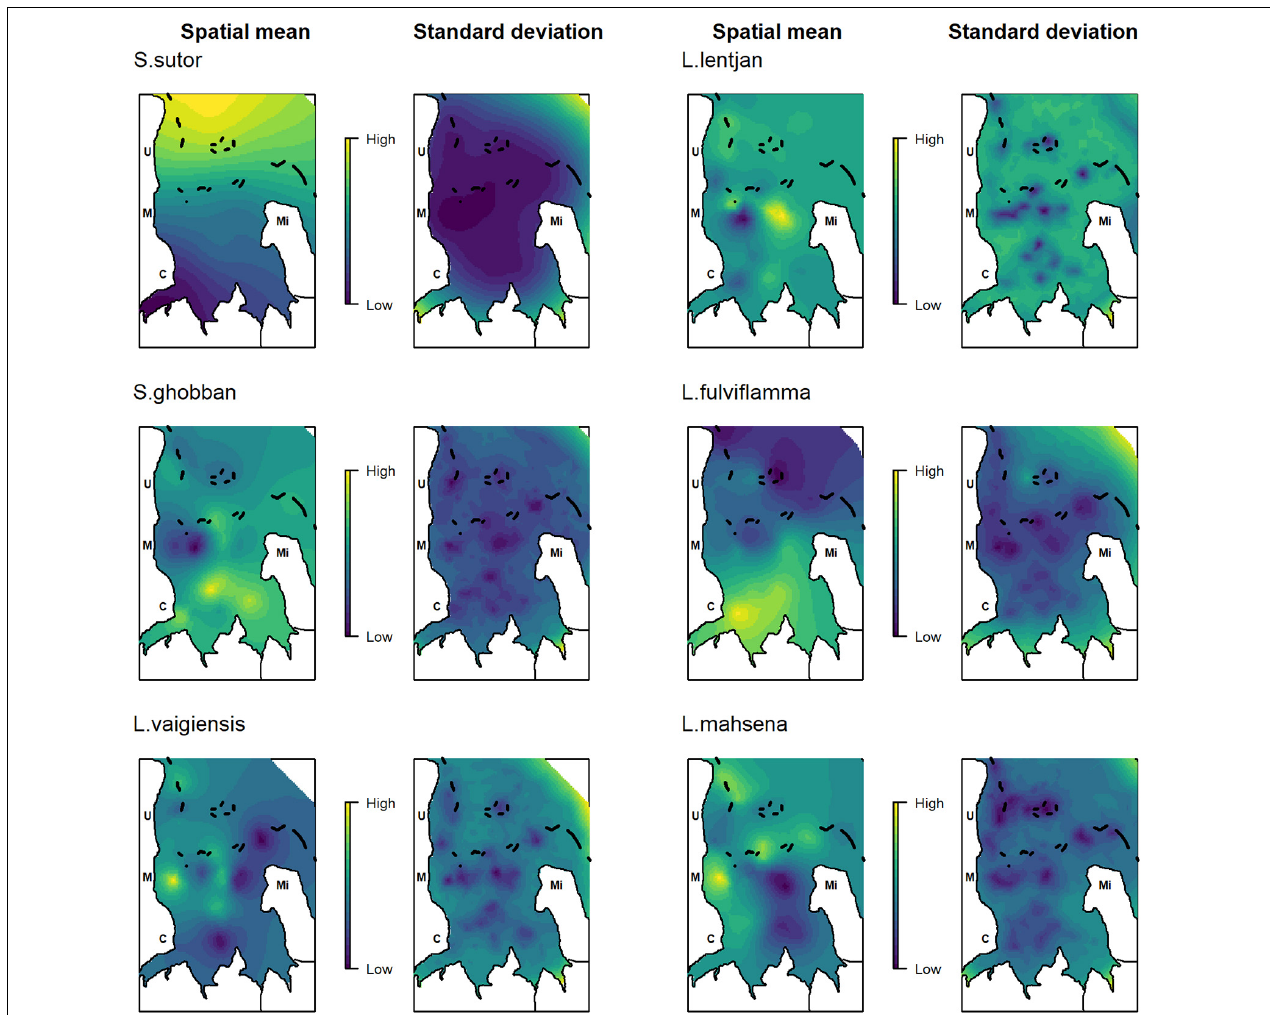
FIGURE 4 | Posterior mean and standard deviation of the spatial random effect. Letters indicate the position of the villages: C, Chwaka; M, Marumbi; U, Uroa; Mi, Michamvi. Black lines depict the reef.